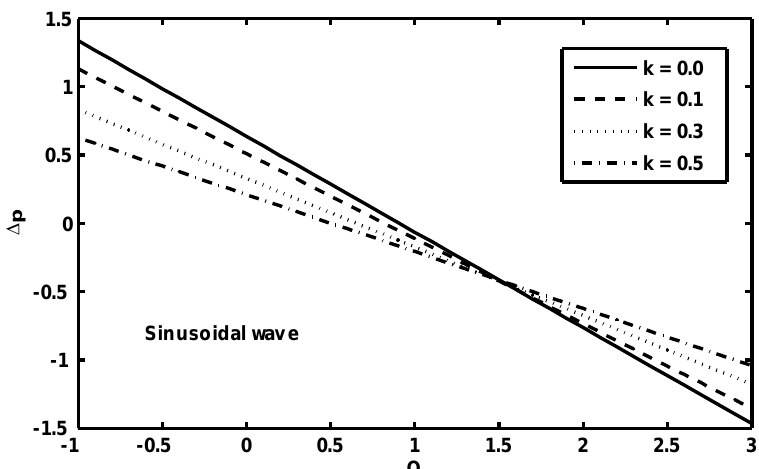
Figure 2. Variation of ∆ p with Q for di ff erent values of k for fixed a = 0.7, α = 0.2, b = 0.7, d = 1.5, Θ = π , M = 0.5, Re = 0.4, ϕ = 6